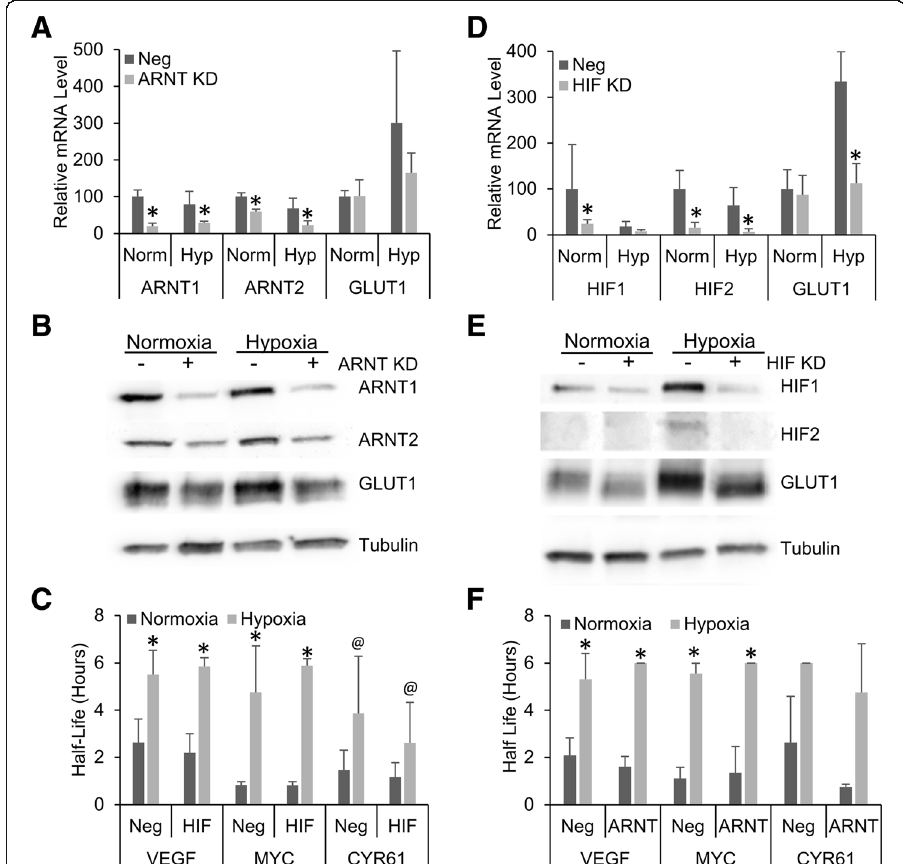
Fig. 2 Hypoxic mRNA stability does not require HIF transcriptional activity. HEK293T cells were simultaneously transfected with siRNAs targeting ARNT1 and 2 (ARNT KD), HIF-1 α and 2 α (HIF KD) or negative control siRNA (Neg) for 48 h before being exposed to 24 h of Normoxia or Hypoxia (1% O 2 ) in the presence of 1 g/L glucose. Cells were treated with actinomycin D for 0, 1 or 2 h. RT-PCR ( a, d ) and western blotting ( b, e ) of 0 h time point were used to assess effectiveness of knockdown. c, f mRNA levels of VEFG, MYC and CYR61 were determined via qPCR, normalized to GAPDH and 0 h time point and half-lives determined. Data represents average of N=3±SD for each condition. * P ≤ 0.05; @ P ≤ 0.1 from respective